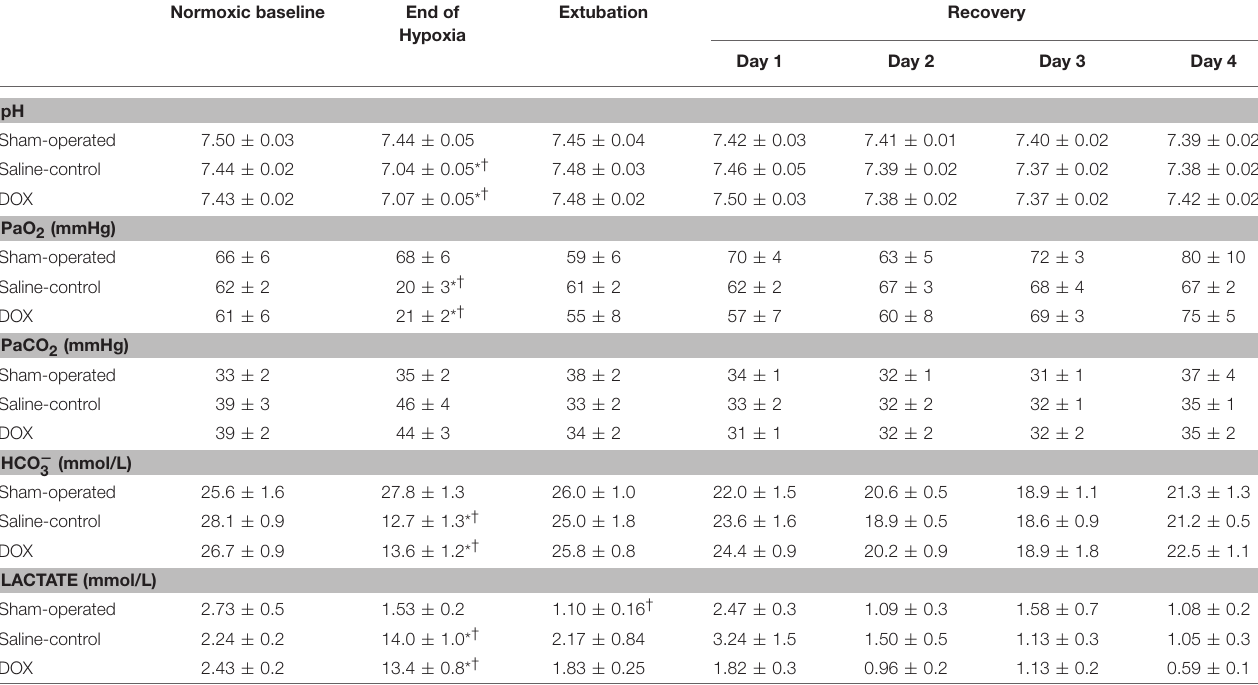
TABLE 1 | Changes in arterial blood gases during hypoxia and recovery. Normoxic baseline End of Extubation Hypoxia